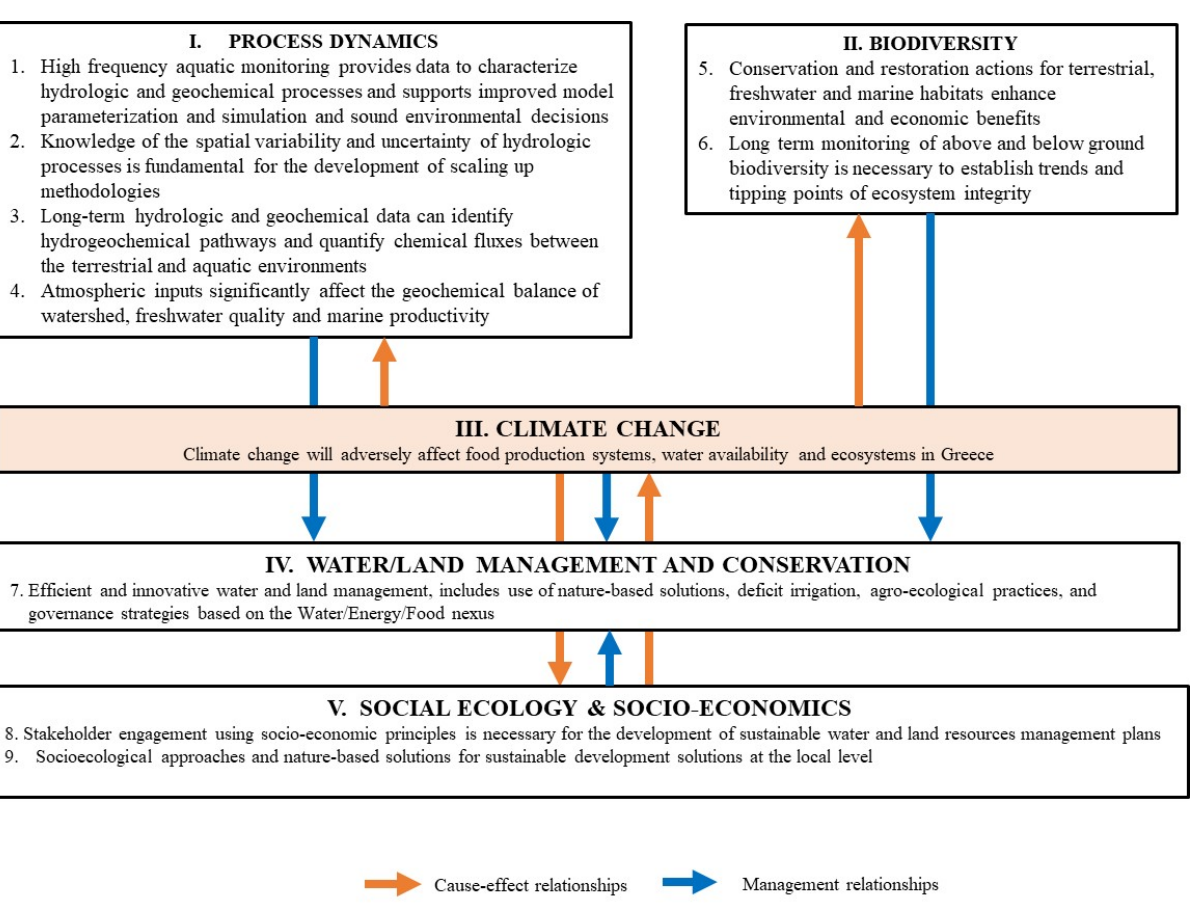
Figure 11. Scientific hypotheses to be tested and interrelationships among the scientific areas at the LTER-Greece observatory network.